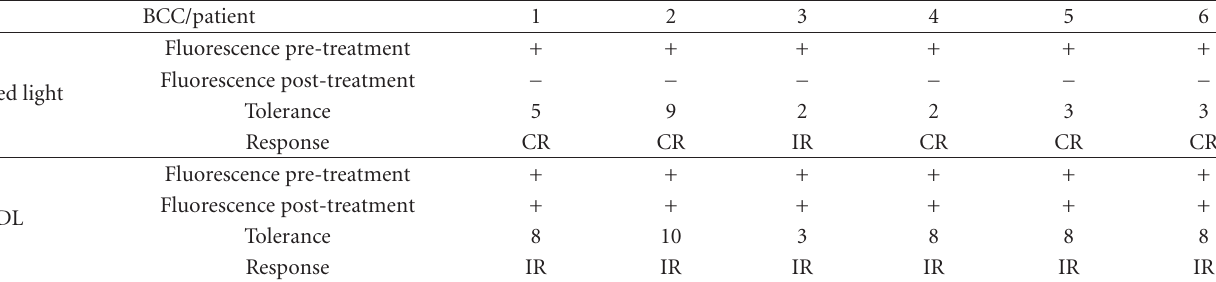
Figure 1: A basal cell carcinoma treated with PDT. The right half was treated with PDL and the left half with red light. Previous to the second session less inflammation was observed in the right half. A week after treatment less crustal formation appeared in the left half. After three months partial response is showed in the half treated with PDL. Table 1: Summary of the patients and treatment